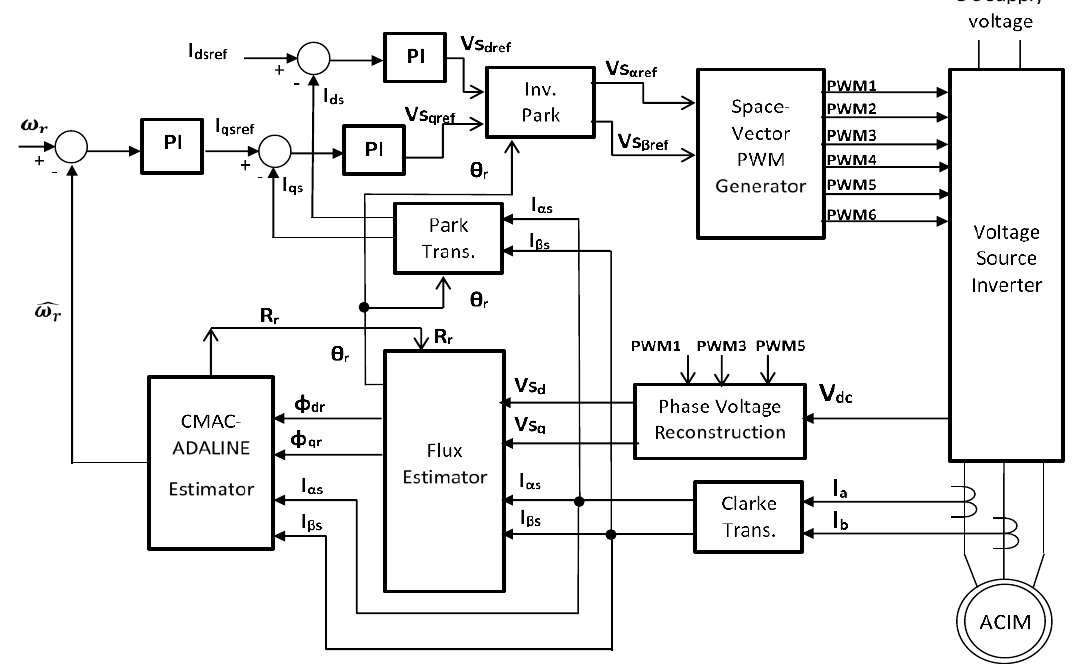
Figure 5. CMAC-ADALINE block connected to the FCO